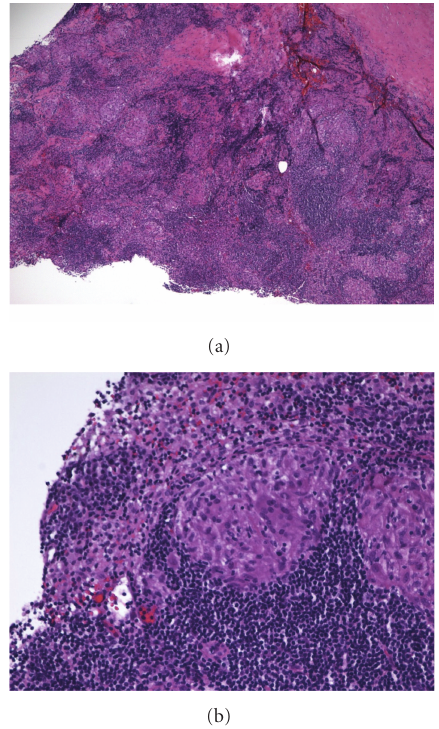
Figure 4: (a) Lymph node biopsy showing noncaseating granu- lomatous change (low power). (b) Lymph node biopsy showing noncaseating granulomatous change (high